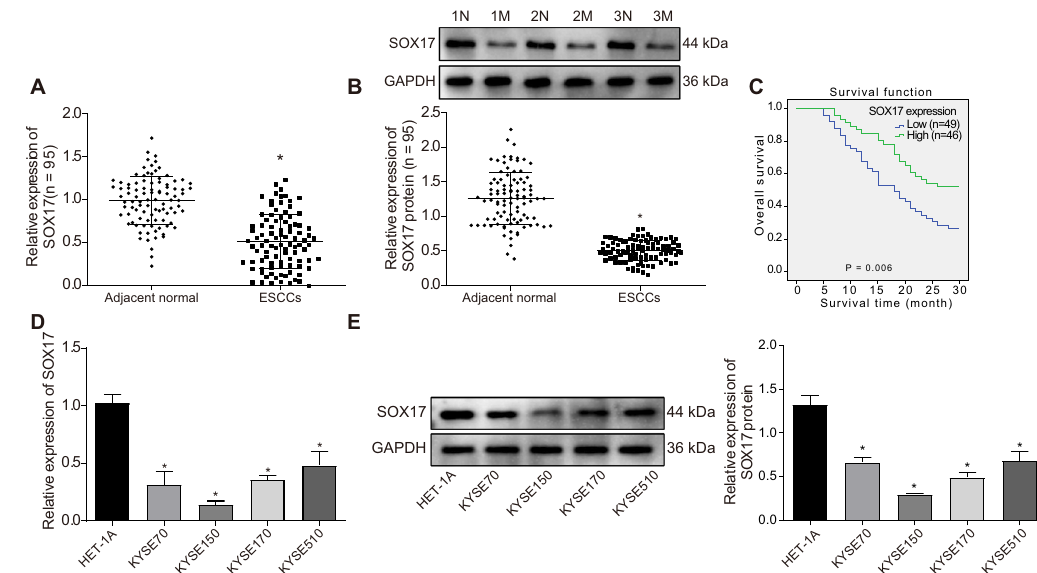
Fig. 1 SOX17 expression was poorly expressed in ESCC tissues and cells, which was related to the prognosis of ESCC patients. A , B The expression of SOX17 mRNA and protein in ESCC tissues (ESCCs-Tumor group) and adjacent normal tissues (ESCCs-Adjacent normal group) of ESCC patients, measured by qRT-PCR and Western blot. n = 95 in ESCC patients; * p < 0.05 compared with adjacent normal tissues. N: ESCC adjacent normal tissues; M: ESCC tumor tissues. C Correlation between SOX17 expression and OS of ESCC patients analyzed by the Kaplan- Meier method. The expression of SOX17 mRNA and protein in human esophageal epithelial cell line HET-1A and ESCC cell lines KYSE70, KYSE170, KYSE150, and KYSE510 measured by qRT-PCR ( D ) and Western blot ( E ). * p < 0.05 compared with HET-1A cells. Measurement data were expressed as mean ± standard deviation. Paired t test was adopted to compare tumor tissues and adjacent normal tissues. The data of multiple groups were compared by one-way ANOVA, with Tukey ’ s post-hoc test. Cell experiments were repeated in RESULTS SOX17 is poorly expressed in ESCC and this low expression indicates poor prognosis of ESCC patients First, we aimed to investigate the effect of SOX17 on the radioresistance of ESCC and its relatively downstream mechanism. As shown in Fig. 1A, B, the expression of SOX17 was lower in ESCC tissues than adjacent normal tissues. The overall survival (OS) of the patients with lower SOX17 expression was shorter (Fig. 1C), suggesting the association of low expression of SOX17 with poor prognosis of ESCC patients. In addition, the results of qRT-PCR and Western blot demonstrated that versus HET-1A cells, the expression of SOX17 was reduced in ESCC cell lines (KYSE70, KYSE170, KYSE150, and KYSE510), with KYSE150 cells presenting the lowest SOX17 expression (Fig. 1D, E) and thus selected for the experiments related to SOX17. The above results illustrated that SOX17 was under- expressed in ESCC tissues and cells, and this downregulation linked to the poor prognosis of ESCC patients.